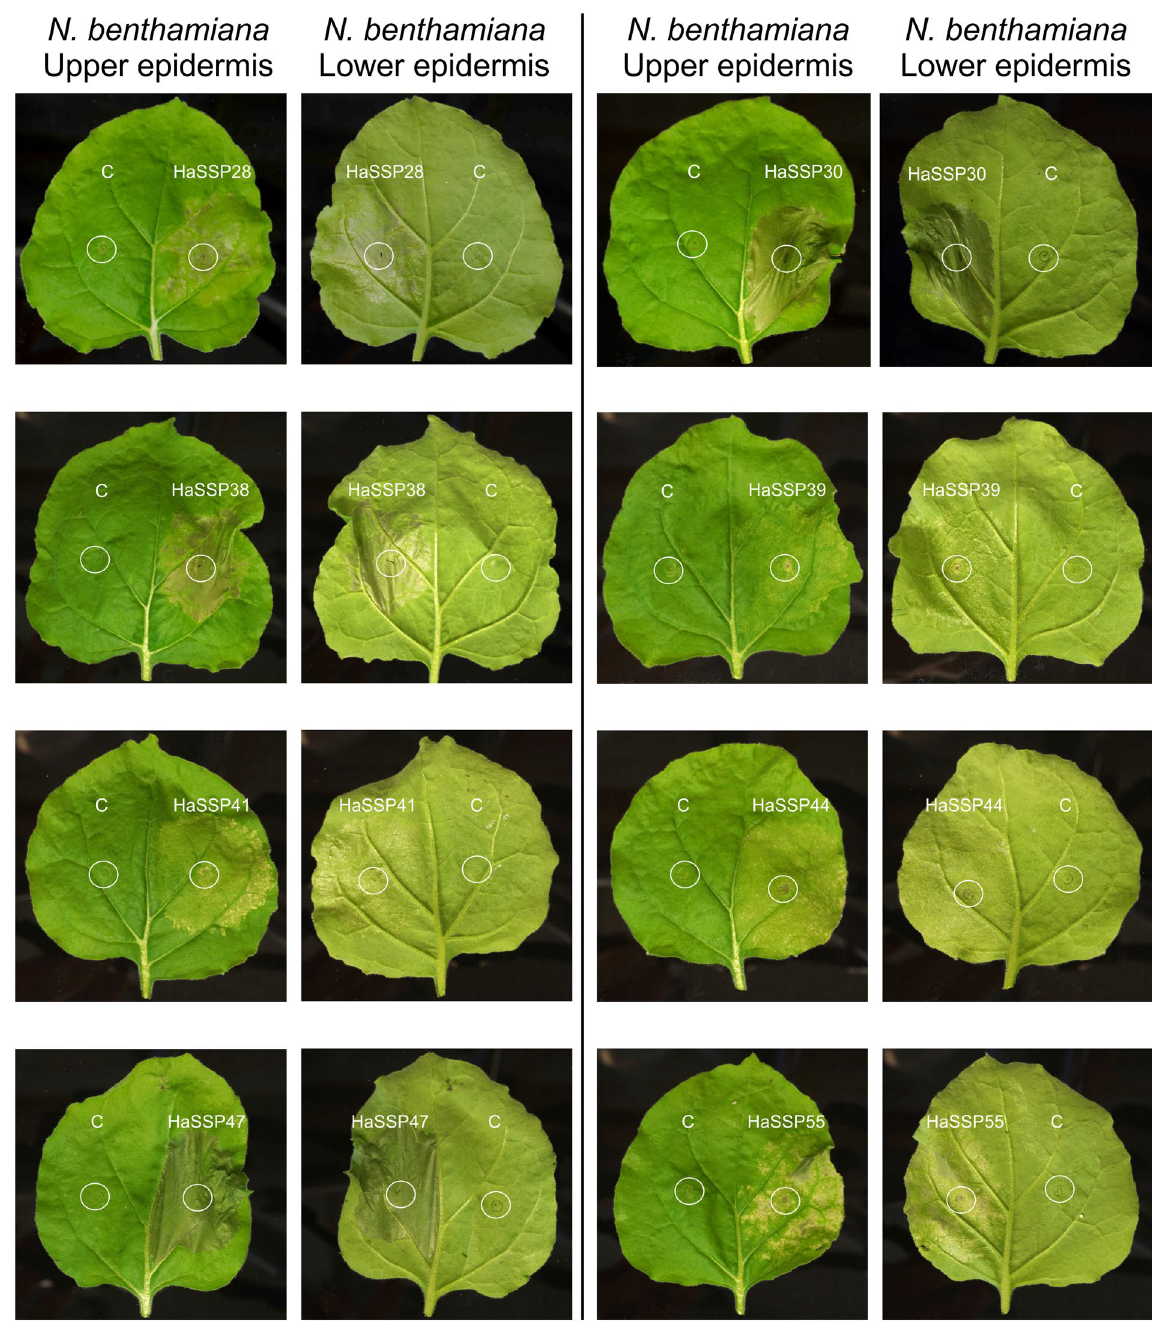
Figure 3. Chlorosis and cell death induced by transient expression of the H. annosum small secreted protein (HaSS) encoding genes in Nicotiana benthamiana . HaSSPs were custom synthesised into the pUC57 vector. Each candidate gene was cloned into the pICH86988 expression vector by Golden Gate cloning, generating pICH86988-HaSSP. The vector was introduced into Agrobacterium tumefaciens GV3101 followed by agroinfiltration into Nicotiana benthamiana leaves. The plants were incubated in a growth room with 12 h/12 h, night/day photoperiods at 20–24 °C and 60% relative humidity (RH). The infiltrated leaves were monitored for 2 to 6 days post-infiltration